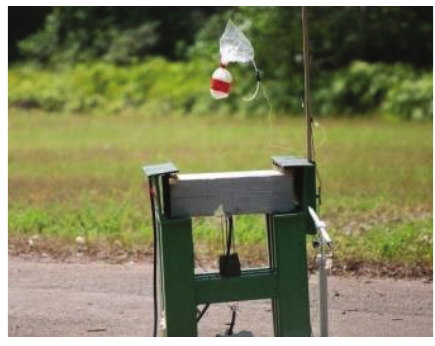
Figure 2: Field blast test setup.